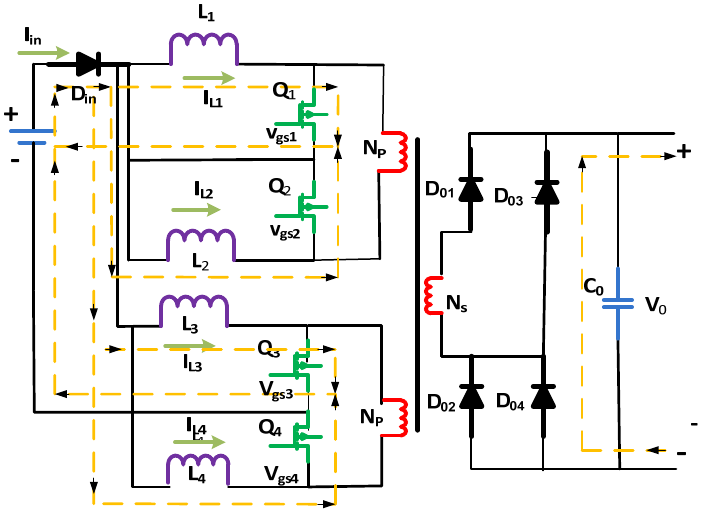
Figure 4. Second mode of the circuit.